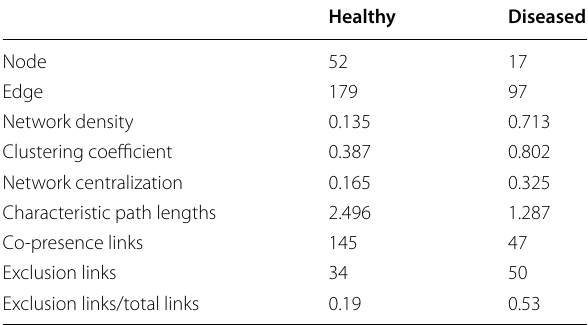
Table 1 Overall characteristics of the microbial networks of core microbiota corresponding to health state